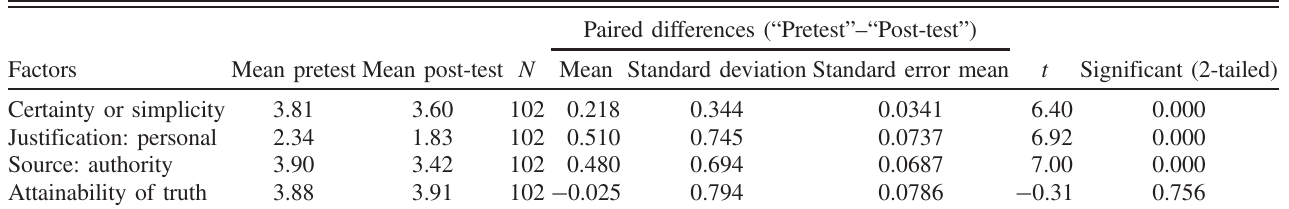
Paired differences ( “ Pretest ” – “ Post-test ” )